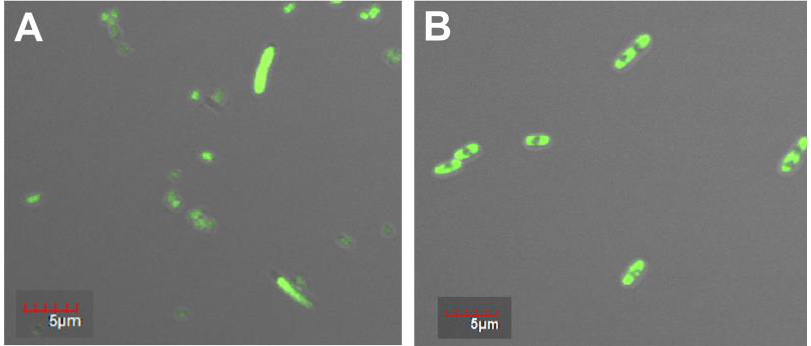
Figure 2. Fluorescence microscopy images of E. coli cells expressing GFP ( A ) and PldA-GFP ( B ).